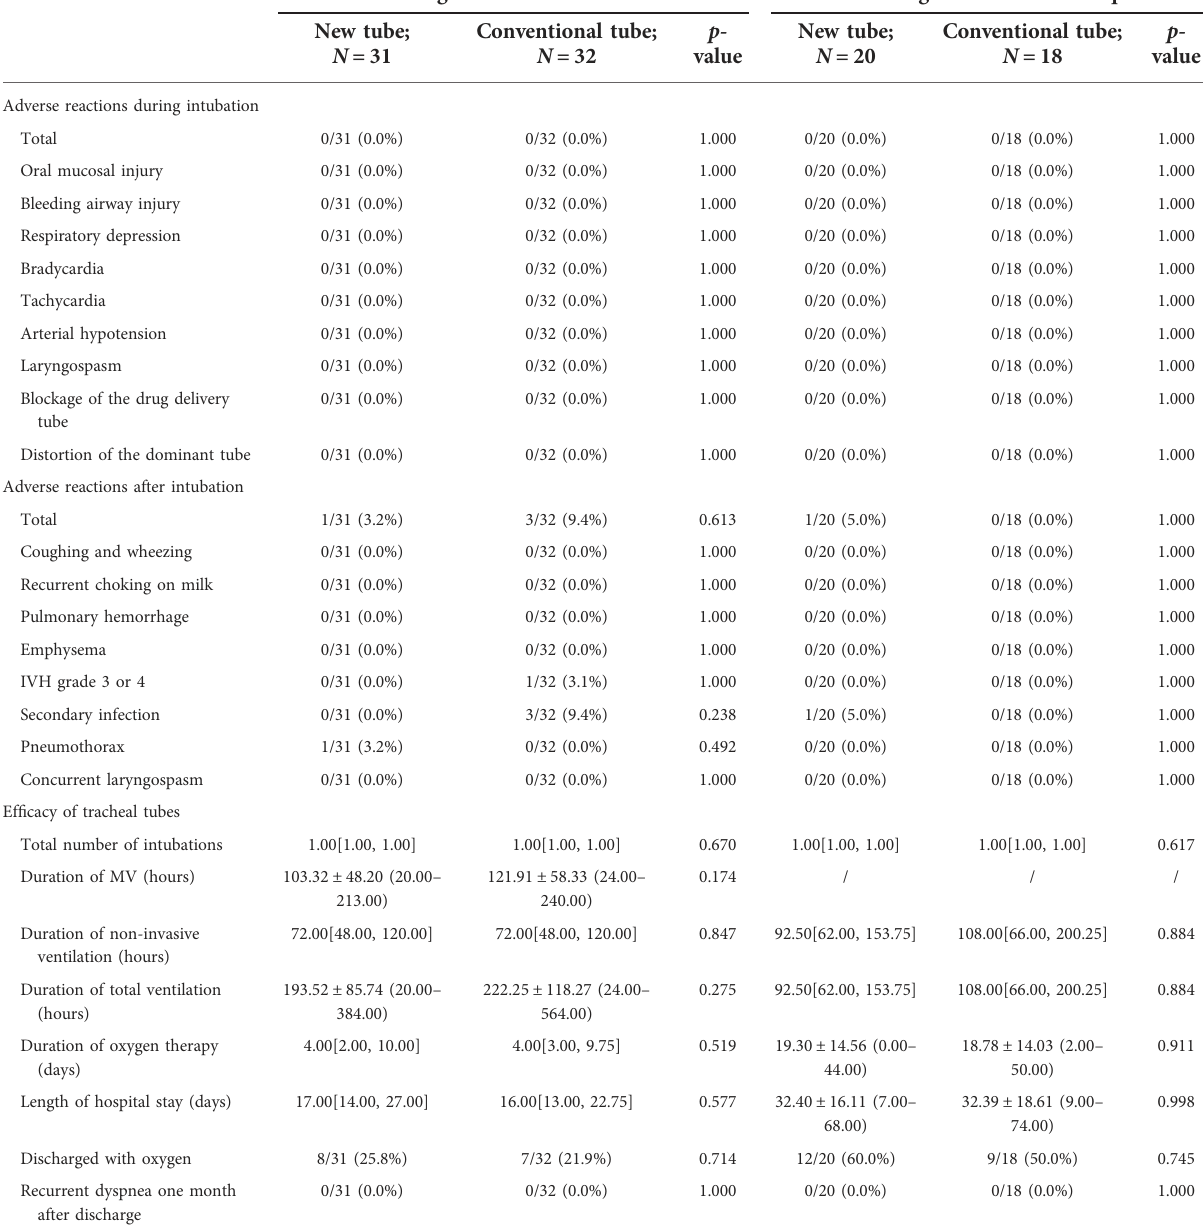
TABLE 8 Clinical outcomes of neonates receiving invasive mechanical ventilation and the inSurE